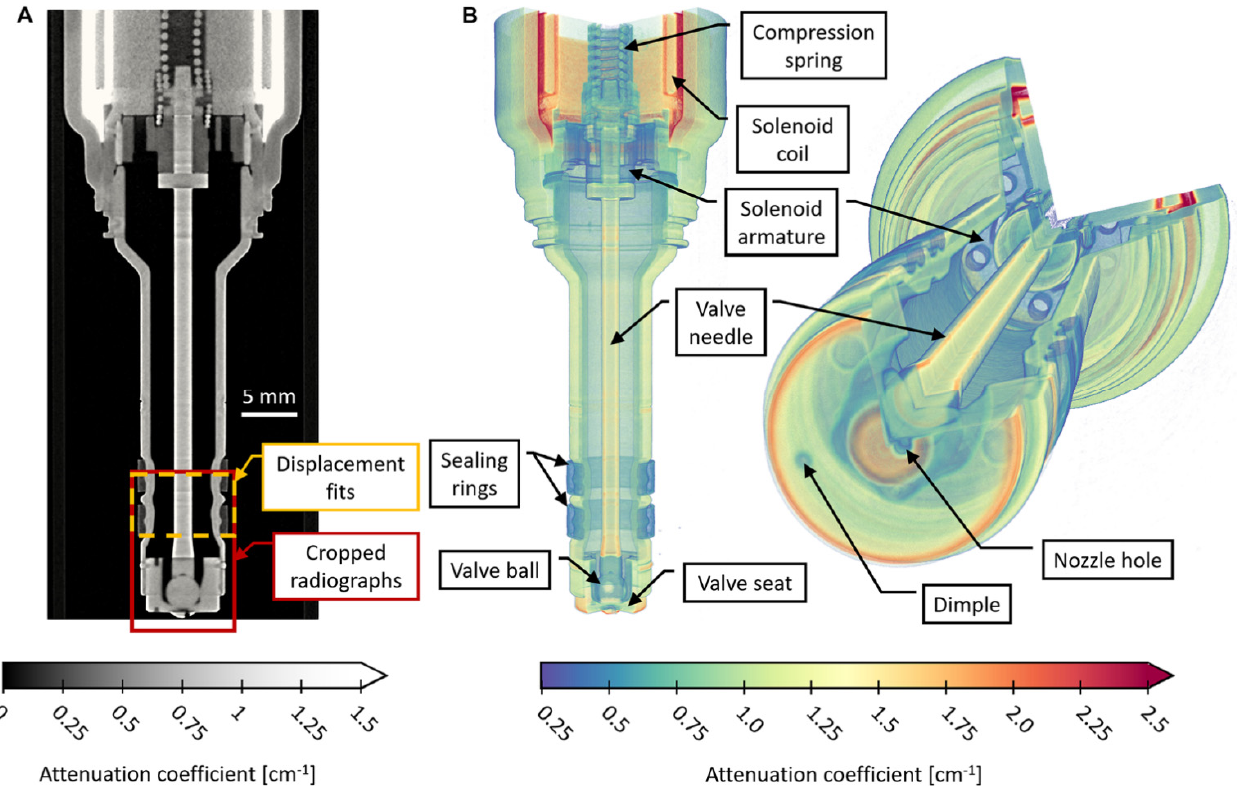
Figure 2. Neutron CT reconstruction of single-hole gasoline direct injector. ( A ) Slice from CT reconstruction with an illustration of regions targeted in the high-speed neutron image sequence and time-series displacement fits. Fuel flows from top to bottom. ( B ) Sectioned volumetric rendering of the injector illustrating the internal geometry and features of the device.